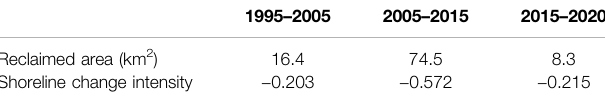
TABLE 3 | Intensity of Sanmen Bay ’ s shoreline change between 1995 and 2020.